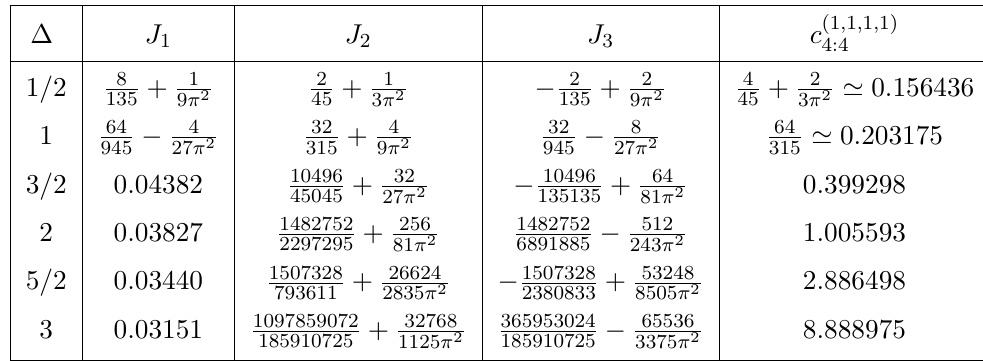
. J 1 is obtained by numerical 4:4